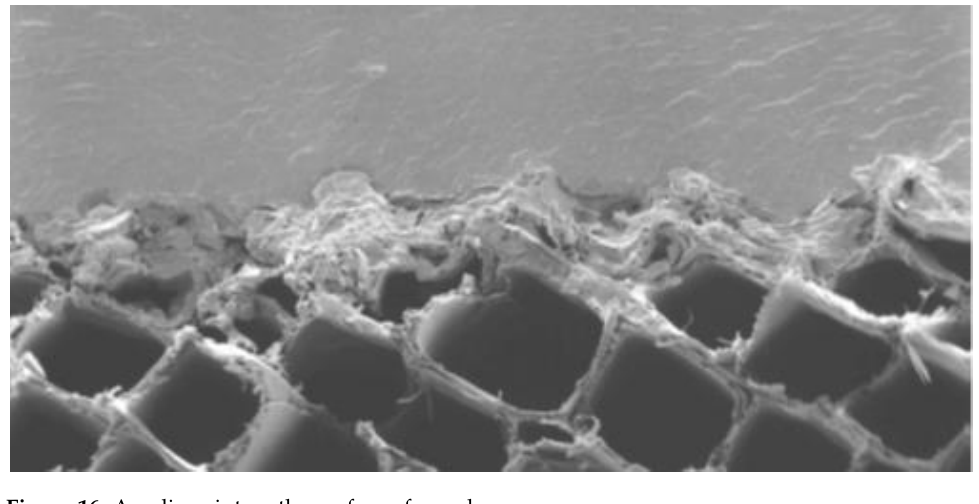
Figure 16. Acrylic paint on the surface of wood.